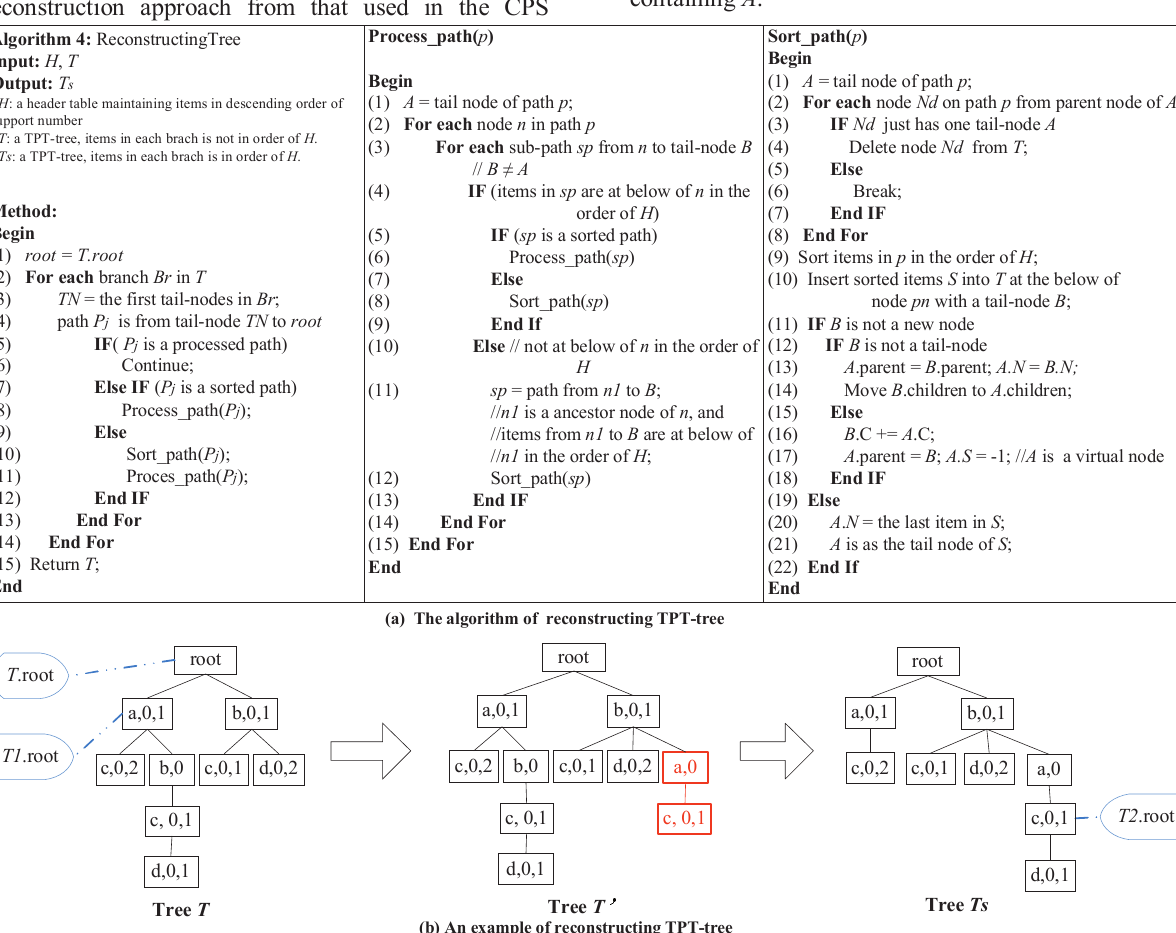
Fig. 6. Reconstruction Algorithm of TPT-tree and an